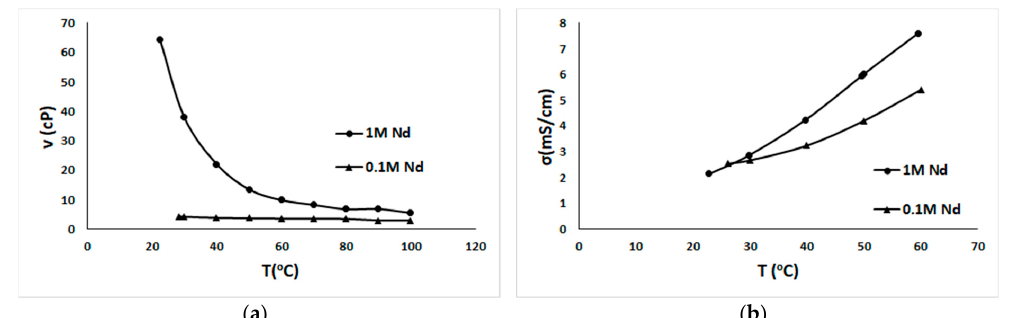
Figure 2. ( a ) Viscosity measurements vs. temperature (T); ( b ) Conductivity measurements vs. temperature